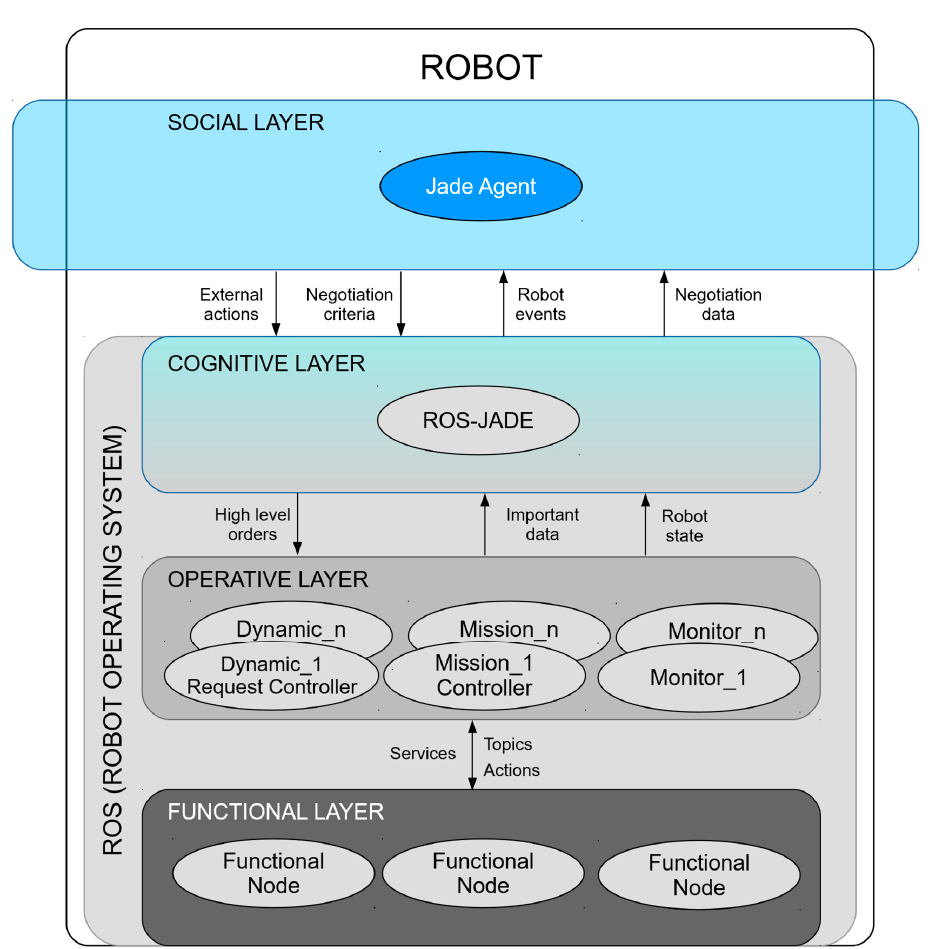
Figure 1. ROS-JADE integration multi-layer architecture.